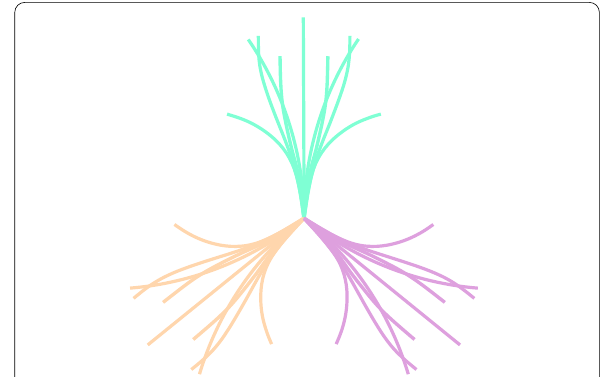
Figure 5 MP cluster rotation transformation